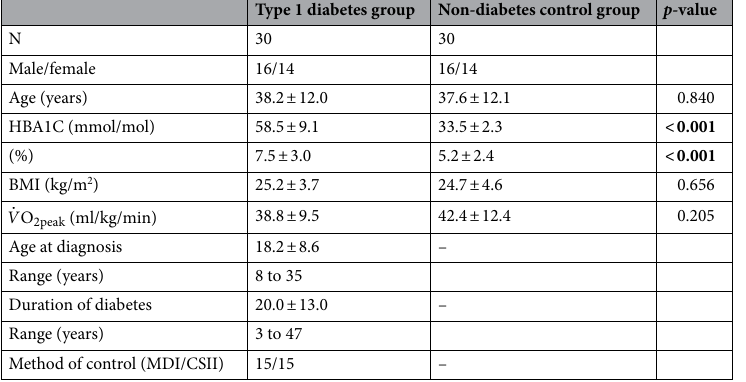
Table 1. Participant demographic data. Bold signifies p ≤ 0.05. Data presented as mean ± SD. P value from independent samples